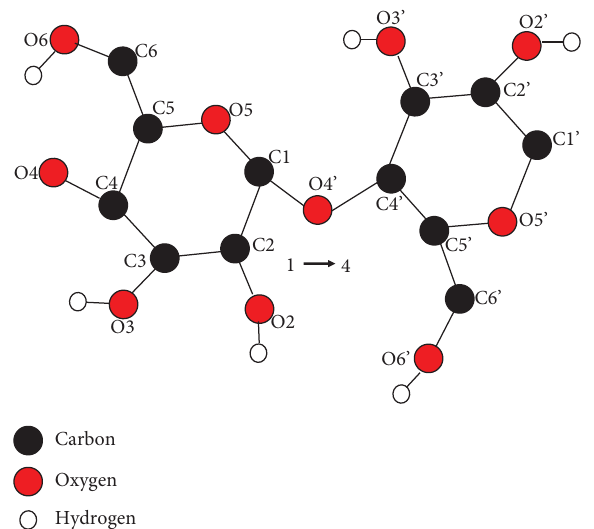
Figure 1: Structure and nomenclature of cellulose. Note that C4 ′ is linked to C1 via O4 ′